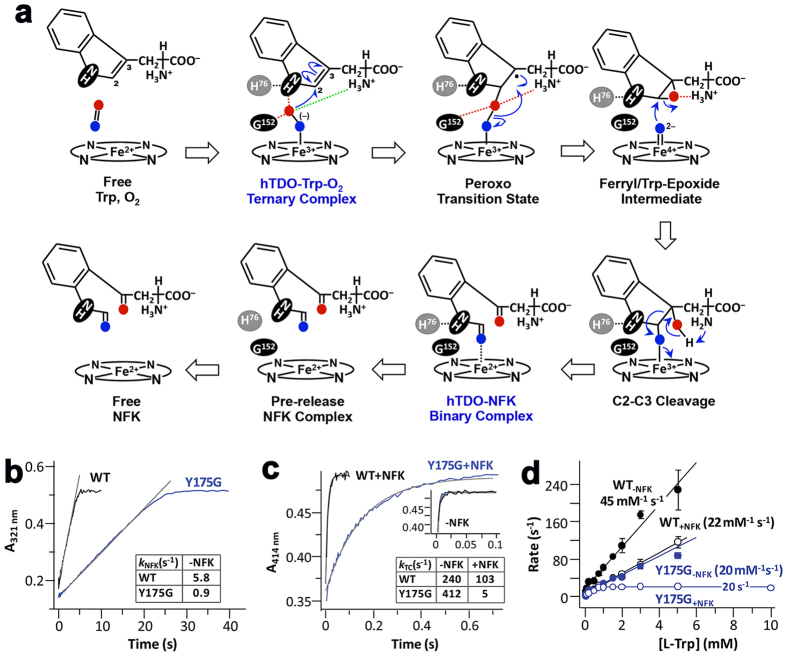
Catalytic mechanism of hTDO.(a) A two-step, ferryl-based mechanism for the dioxygenation of L-Trp. The two complexes observed in the current crystal are labeled in blue. The electrostatic interaction between the terminal oxygen of O2 and the main-chain ammonium ion of L-Trp is indicated with the dashed lines in green. Modified from earlier publications313233. (b) Stopped-flow kinetics showing that the multiple turnover activity of the enzyme is reduced by the Y175G mutation. The production of NFK was monitored by absorbance at 321 nm. (c) Stopped-flow kinetics showing that the presence of NFK (8 mM) retarded Trp-O2 binding to the deoxy enzymes to form the ternary complexes, especially for the Y175G mutant. TC: ternary complex, monitored by absorbance at 414 nm. The inset shows the kinetic traces obtained in the absence of NFK. (d) Trp binding kinetics and its retardation by NFK. The Trp binding rate of the Y175G mutant is linear with [Trp], leading to a kon of 20 mM−1s−1. In the presence of 8 mM NFK, the same kon was observed at low [Trp]; as the [Trp] was raised above 1 mM, the rate leveled off at 20 s−1, as the reaction was rate-limited by NFK release. The data in (b) and (c) were taken from Supplementary Figs 4 and 5.